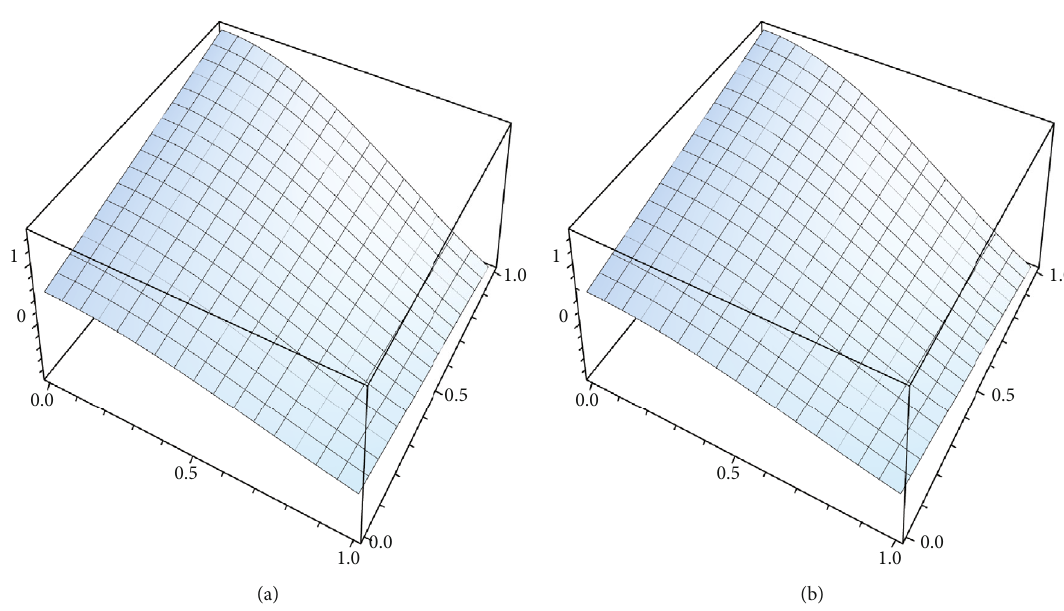
Figure 5: The FRDTM solutions u ð x , y , z Þ : (a) nonfractional exact α = 2 and (b) nonfractional tenth-order approximate α = 2 .